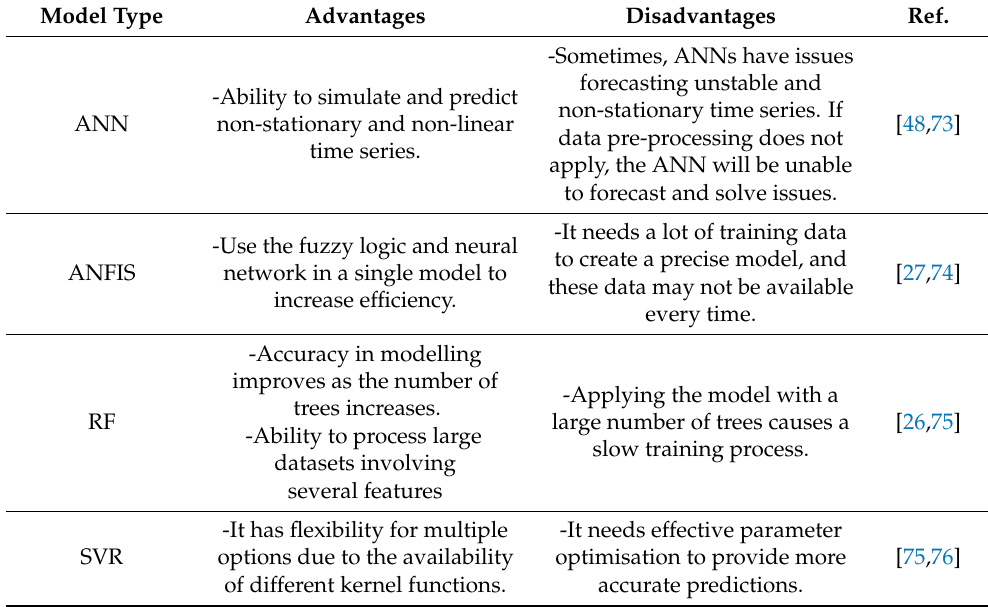
Table 6. Advantages and disadvantages of stand-alone machine learning